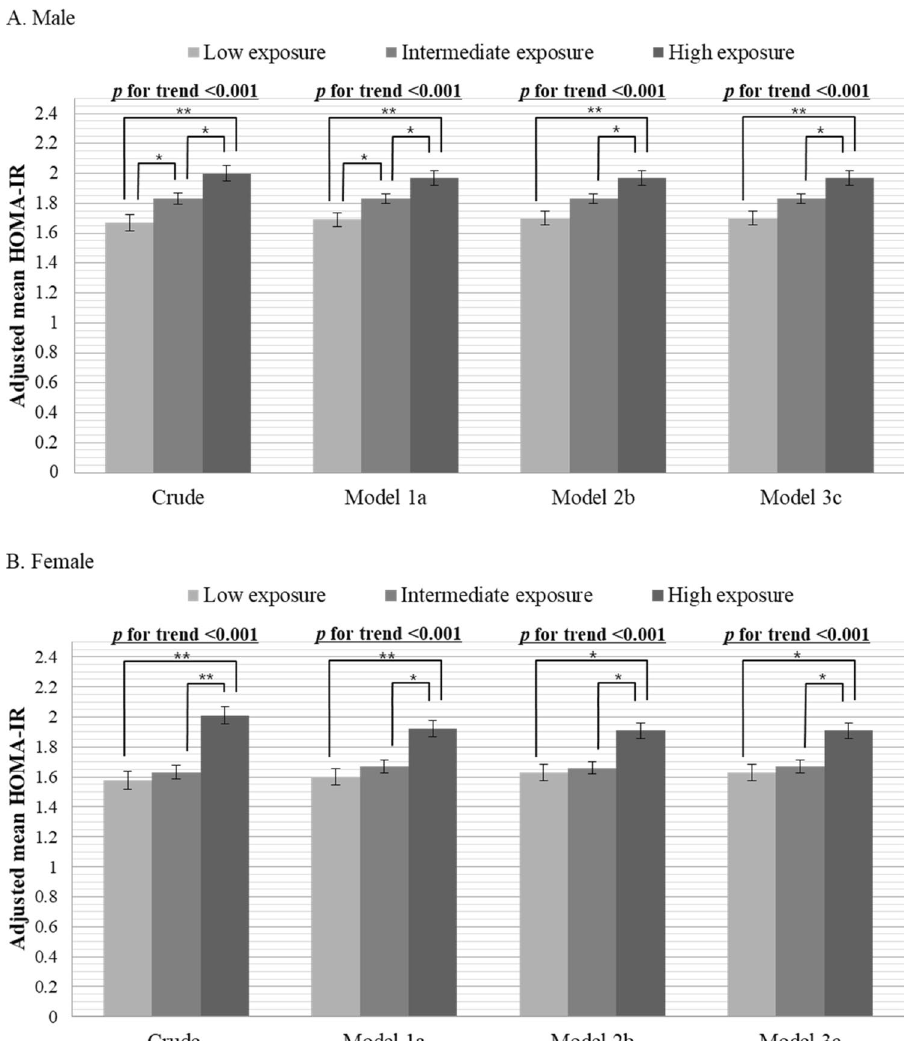
Figure 1. Adjusted mean HOMA-IR according to long-term PM 10 exposure. Adjusted mean HOMA-IR was calculated using linear regression analysis. Exposure to PM 10 was classified using quartiles of PM 10 concentration as low exposure (quartile 1: mean = 40.22, SD = 3.29), intermediate exposure (quartiles 2 and 3: mean = 49.19, SD = 2.95), and high exposure (quartile 4: mean = 60.63, SD = 4.91). * p < 0.05, ** p < 0.001. a Model 1 was adjusted for age, BMI, smoking status (never, former, or current smoking), alcohol consumption (never, former, or current consumption), regular physical activity (yes or no), hypertension, and dyslipidemia. b Model 2 included the variables in Model 1 plus VAT and SAT areas as covariates. c Model 3 included the variables in Model 1 plus VAT area as a covariate. HOMA-IR homeostasis model assessment of insulin resistance index, PM 10 particulate matter with aerodynamic diameter ≤ 10 μm 3 , BMI body mass index, VAT visceral adipose tissue, SAT subcutaneous adipose